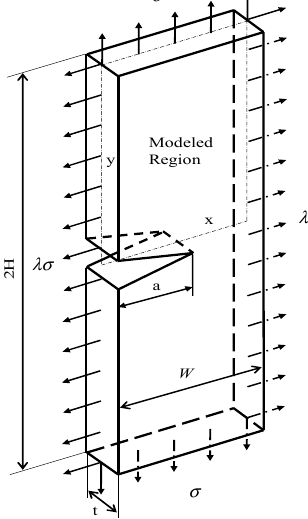
Figure 3. 3D single edge cracked plate (SECP) specimen model.